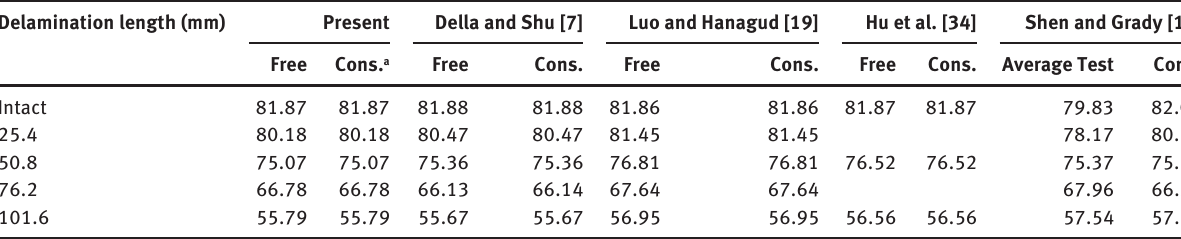
Table 2 Fundamental frequencies (Hz) of the LCB with central delamination located at interface 1.